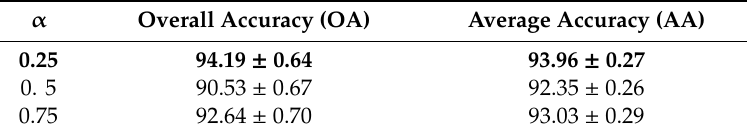
Table 5. Equilibrium parameter α of TDDA